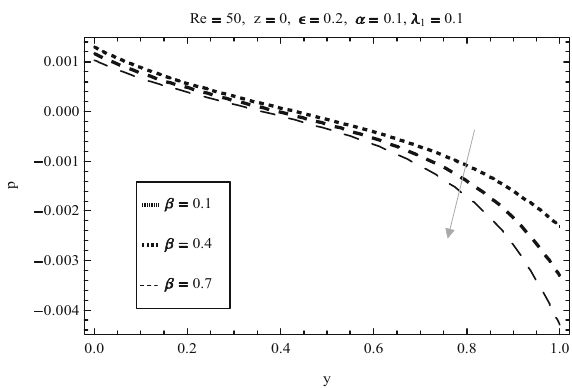
Fig. 15 Variation of p along y for different values of β